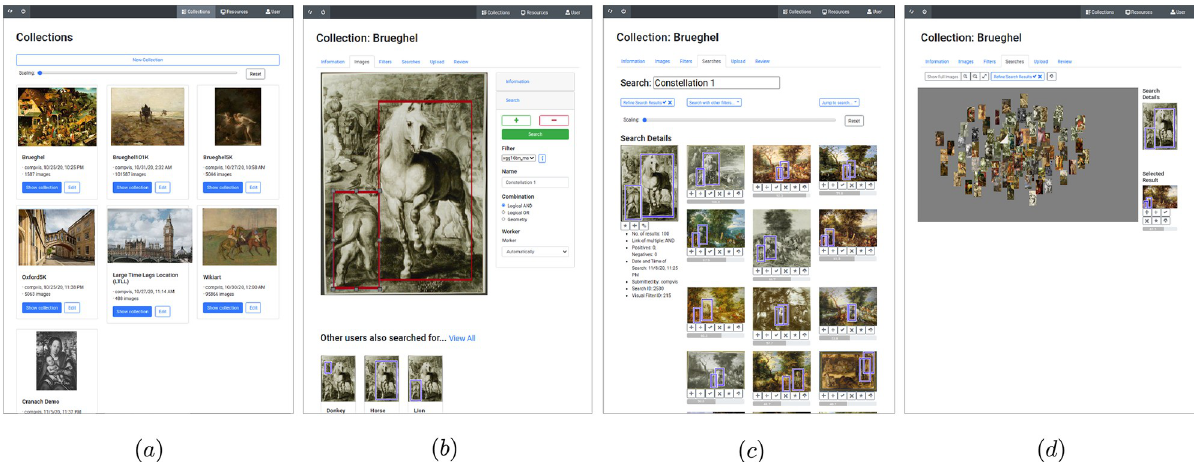
Fig 3. Visualization of the interface workflow. First, the dataset to be searched is selected, or a new dataset is created and initialized (a). Then an image can be chosen, and one or multiple search boxes can be selected and searched across the dataset (b). The retrievals are displayed in an ordered list (c) or with a two-dimensional t-SNE embedding [69] (d). Image material is shared by Wikimedia Commons [5] either as public domain or under a CC0 license.